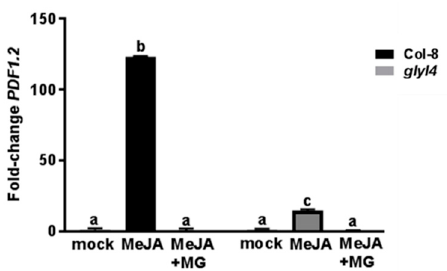
Figure 8. PDF1.2 gene expression analysis in Arabidopsis Col-8 and glyI4 mutant after methyl jasmonate (MeJA) and MeJA + MG treatment. qRT-PCR analysis of PDF1.2 expression in Col-8 and glyI4 leaves treated with a mock solution, MeJA or MeJA + MG. Fold change is relative to the expression in mock-treated plants and normalized to the reference gene PP2AA3 . PDF1.2 gene expression analyses were performed 24 h after each treatment using five-week-old plants. Shown data are means of three biological replicates. Error bars represent SEM. Di ff erent letters indicate statistically significant di ff erence between treatments (two-way ANOVA; Tukey’s test p < 0.0001).